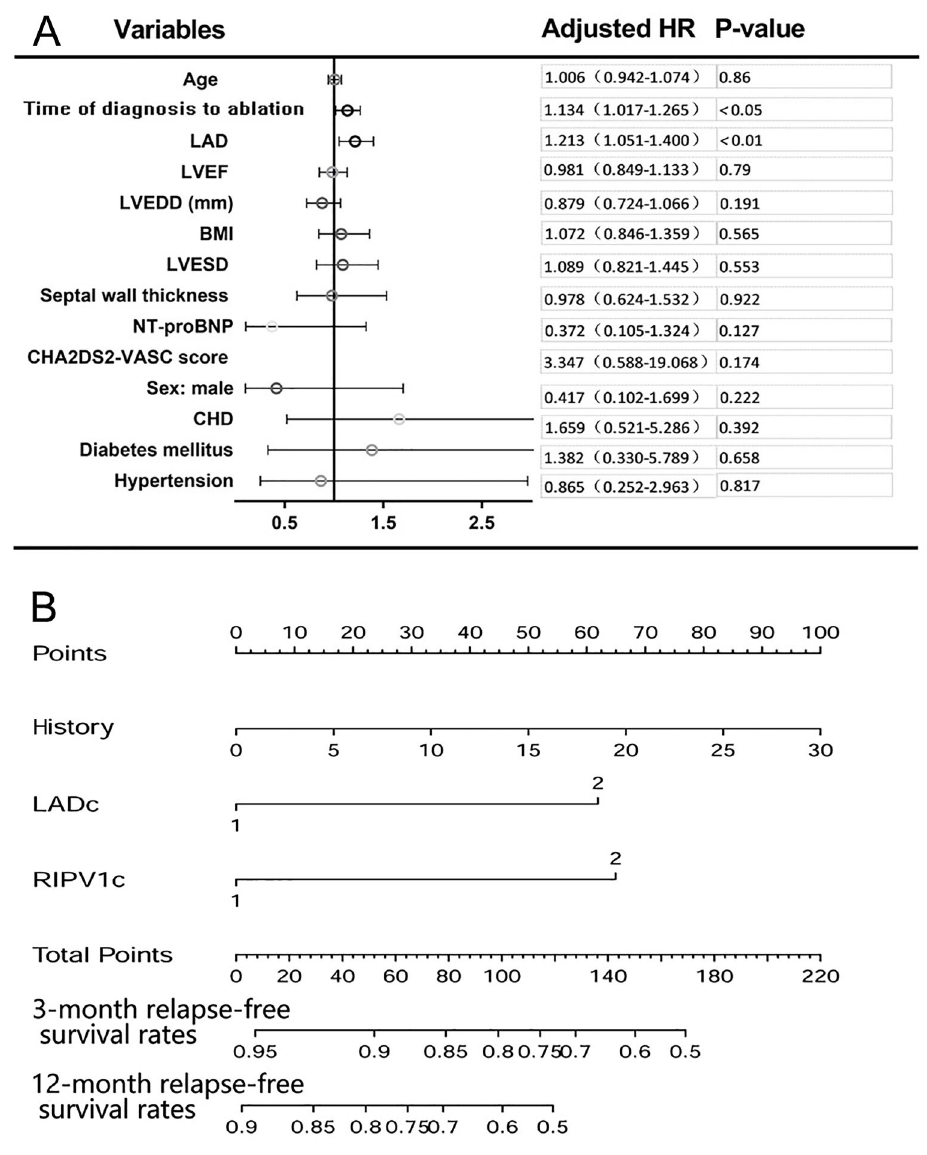
Figure 2. A , Adjusted hazard ratio and 95% con fi dence intervals for each baseline clinical variable between patients with and without atrial fi brillation recurrence during follow-up. CI: con fi dence interval; HR: hazard ratio; LAD: left atrial diameter; BMI: body mass index; CHD: coronary heart disease; NT-proBNP: N-terminal pro brain natriuretic peptide; LVEDD: left ventricular end-diastolic diameter; LVESD: left ventricular end-systolic diameter; LVEF: left ventricular ejection fraction. B , Instruction for using the nomogram. Draw a line perpendicular from the corresponding axis of each risk factor until it reaches the top line labeled "Points." Sum up the number of points for all risk factors then draw a line descending from the axis labeled "Total Points" until it intercepts each of the survival axes to determine 3- and 12-month relapse-free survival rates. Continuous variables such as LAD and major diameter of right inferior pulmonary vein were converted to categorical variables (LADc and RIPV1c), 0 for no and 1 for